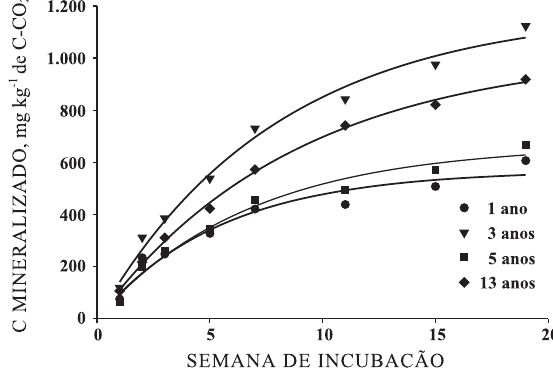
Figura 3. Curvas de C mineralizado acumulado durante período de incubação de solos sob plantações de eucalipto de diferentes idades, ajustadas ao modelo exponencial simples para e da constante de obtenção do C o